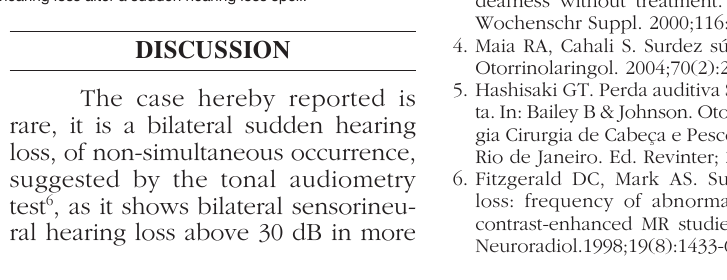
Figure 1. Complementary tests. Upper left-hand image: MRI showing an acoustic neuroma to the right (arrow); upper right- hand image: skull CT showing a hypodense area near the right ventricle horn (circle); lower image: tonal audiometry showing hearing loss after a sudden hearing loss